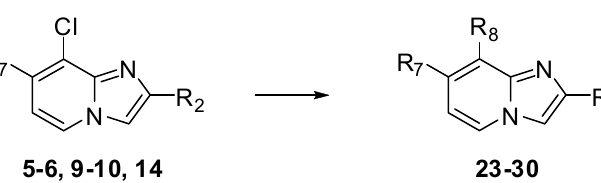
Table 2. Functionalization in position 8 of compounds 5 – 6 , 9 – 10 , 14